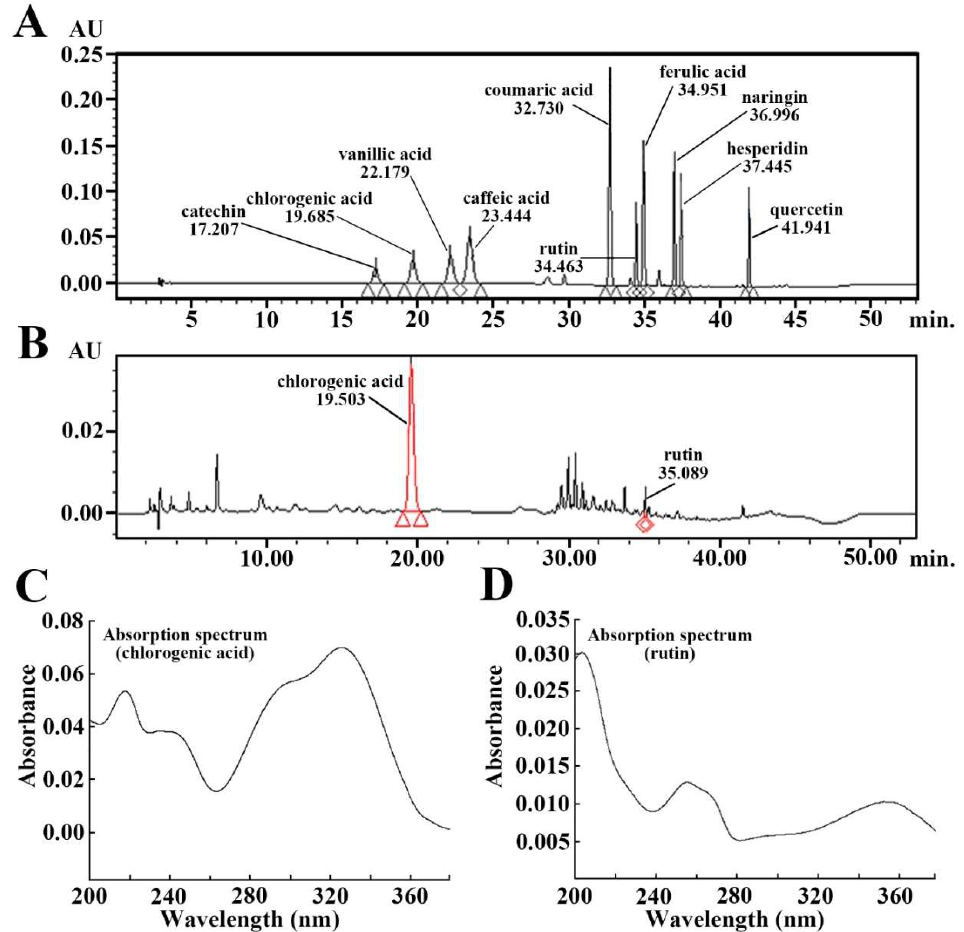
Figure 1. ( A and B ) HPLC chromatograms of standard phenolic compounds ( A ) and aronia melanocarpa extract (AME) ( B ). The retention times of the standard phenolic compounds are 17.207 min (catechin), 19.685 min (chlorogenic acid), 22.179 min (vanillic acid), 23.444 min (caffeic acid), 32.730 min (coumaric acid), 34.463 min (rutin), 34.951 min (ferulic acid), 36.996 min (naringin), 37.445 min (hesperidin) and 41.941 min (quercetin). The retention times of the AME are 19.503 min (chlorogenic